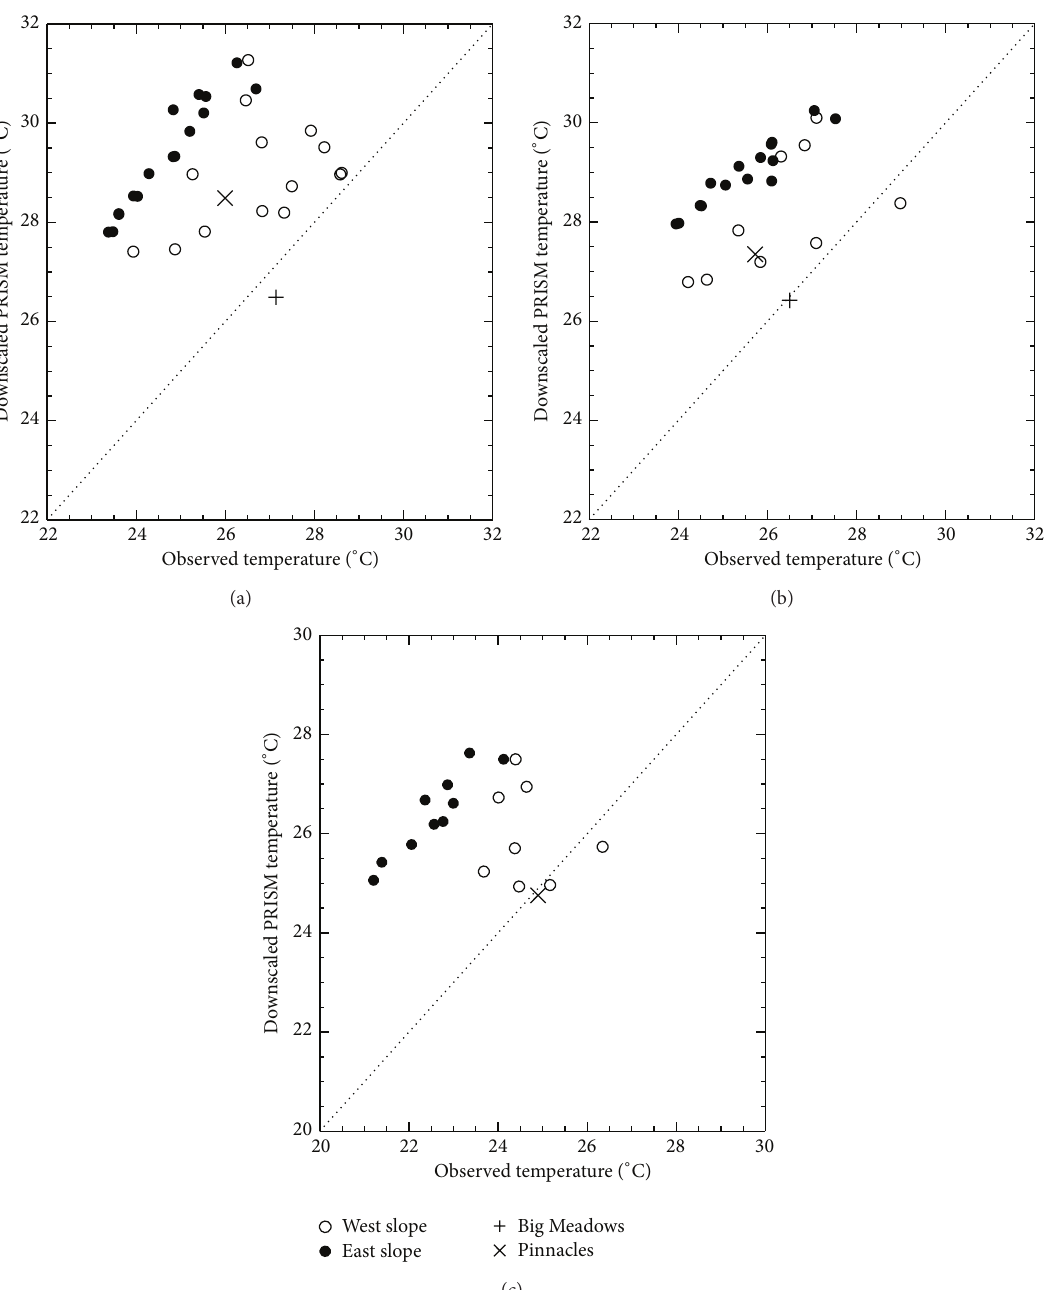
Figure 3: Comparison between observed mean July 𝑇 max from the sensor network and downscaled PRISM for July, 2011 (a), July, 2012 (b), and July, 2013 (c) using PRISM-derived lapse rates. Open circles indicate comparisons along the west slope; filled circles indicate comparisons along the east slope; “+” and “X” denote Big Meadows and Pinnacles, respectively. Black dotted line is the 1: 1 line. Note that Big Meadows measurements are unavailable in 2013. Also note the same range but different scales on the 𝑥 -axis and 𝑦 -axis in panel (c).